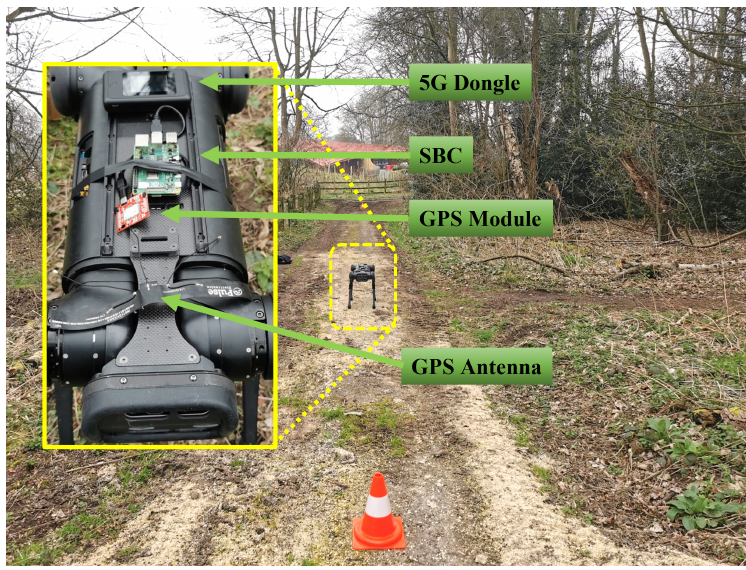
Figure 8. Quadruped robot equipped with a GPS module connected to